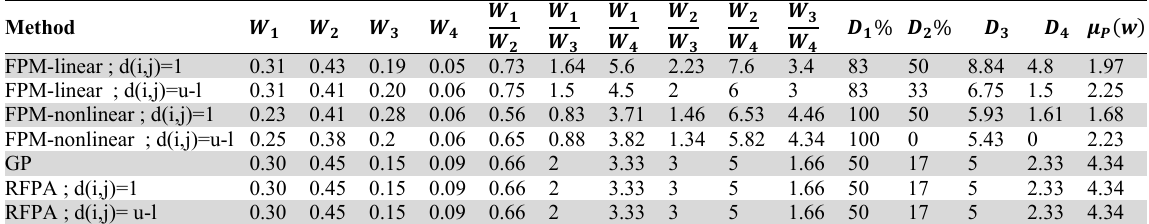
Four-dimensional inconsistent judgments